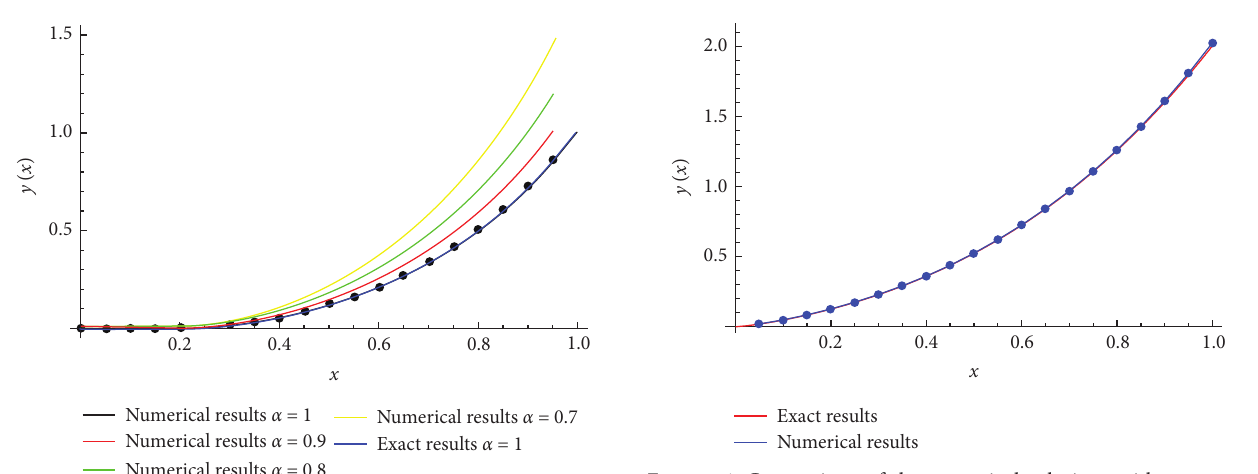
Figure 6: Comparison of the numerical solutions with exact so- lution for n � 10.